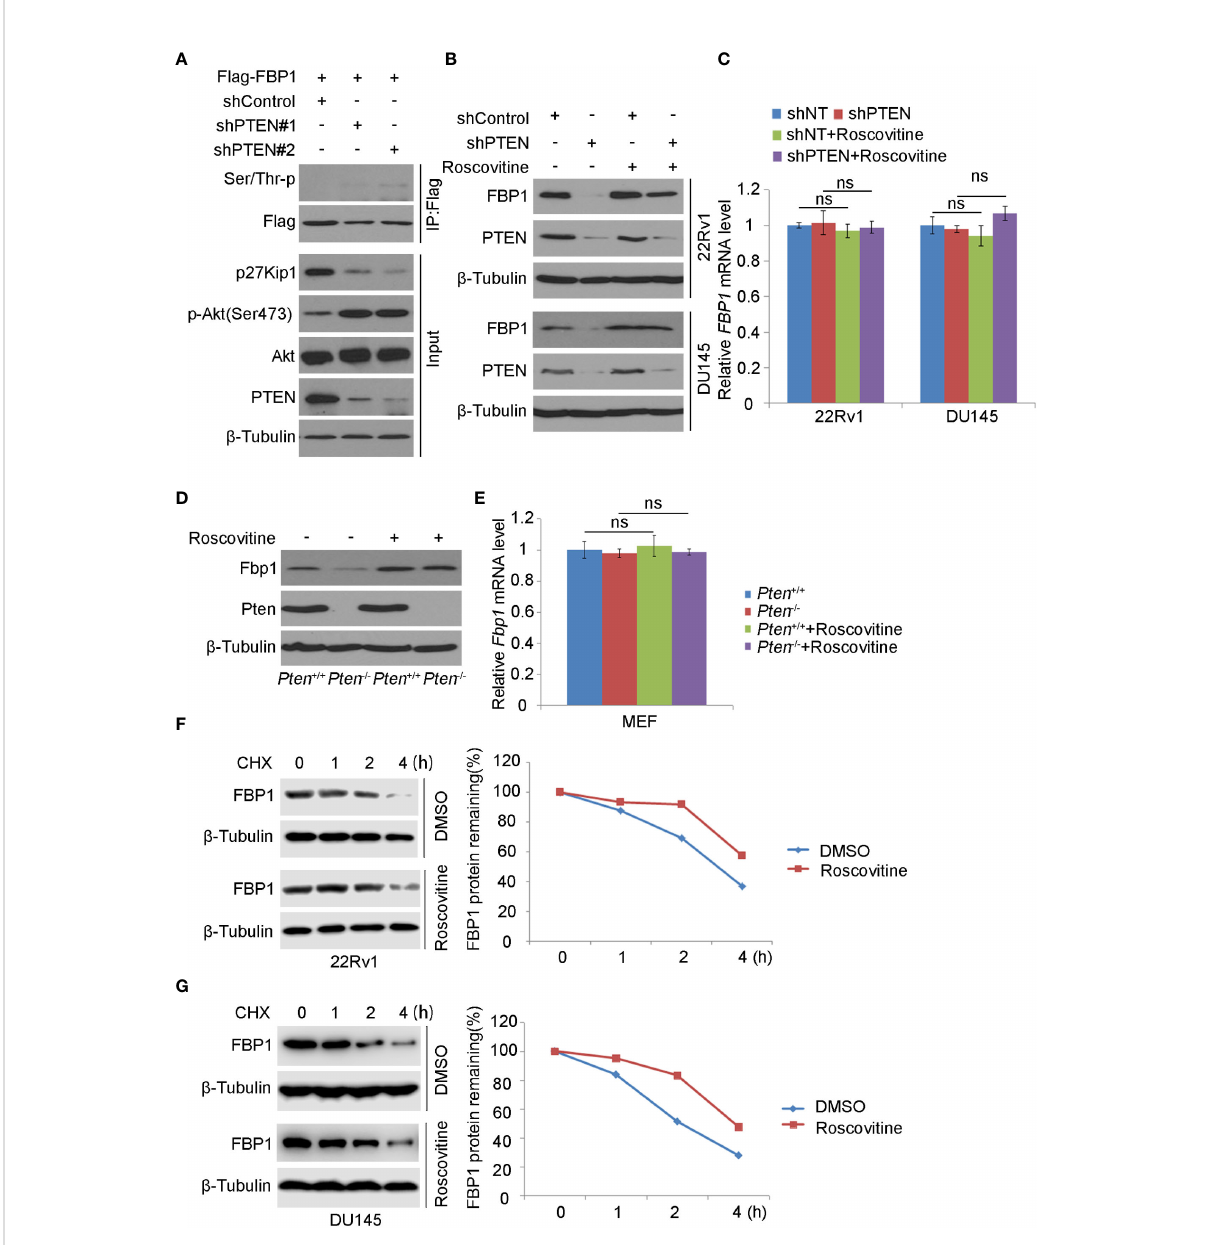
FIGURE 4 CDK inhibitor blocks FBP1 degradation induced by PTEN loss (A) WB was carried out using the whole-cell lysate and co-IP samples obtained from 293T cells transfected with the indicated constructs. b -Tubulin was used as a WB loading control. (B, C) Western blot (B) and quantitative RT-PCR (C) analysis in 22Rv1 and DU145 cells infected with lentivirus expressing control or PTEN-speci fi c shRNAs for 48 hours and treated with Roscovitine for 24 hours. All quantitative data are shown as Mean ± SD (n=3). Student ’ s t test. n.s., not signi fi cant. (D, E) WB (D) and quantitative RT-PCR (E) were carried out in MEFs generated from Pten p/p conditional mice infected with or without lentivirus expression CMV-driven Cre and treated with Roscovitine for 24 hours. All quantitative data are shown as Mean ± SD (n=3). Student ’ s t test. n.s., not signi fi cant. (F, G) WB and quanti fi cation of WB bands were performed in 22Rv1 (F) and DU145 cells (G) treated with Roscovitine for 48 hours followed by treatment with 50 m g/ml cycloheximide (CHX) for different periods of time. At each time point, the intensity of FBP1 was normalized to the intensity of b - Tubulin (a WB loading control) fi rst and then to the value at the 0-h time